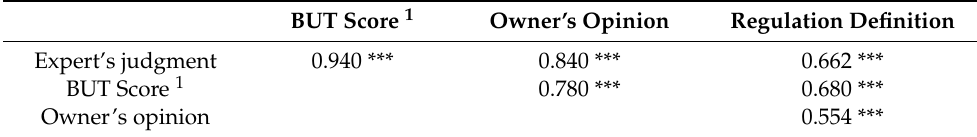
Table 8. Agreement in horse classification (broken or unbroken) among the judgment of the expert, the optimal cut-off of the BUT score, the classification according to the Regulation EC 1/2005, and the owner’s opinion (Cohen’s